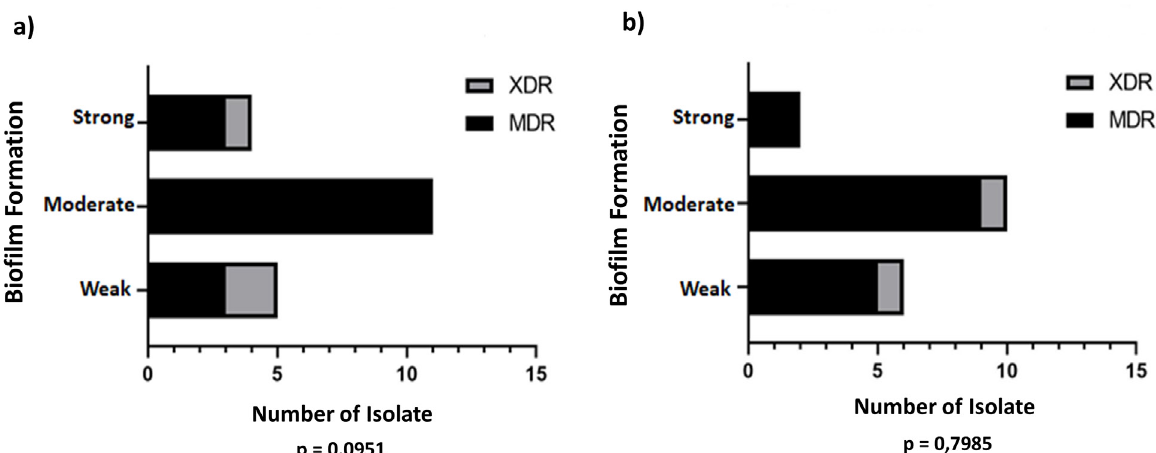
Figure 3. Correlation between biofilm formation and resistance profiles of Acinetobacter spp. isolates in Recife – PE – Brazil. a) Infection isolates and b) Colonization